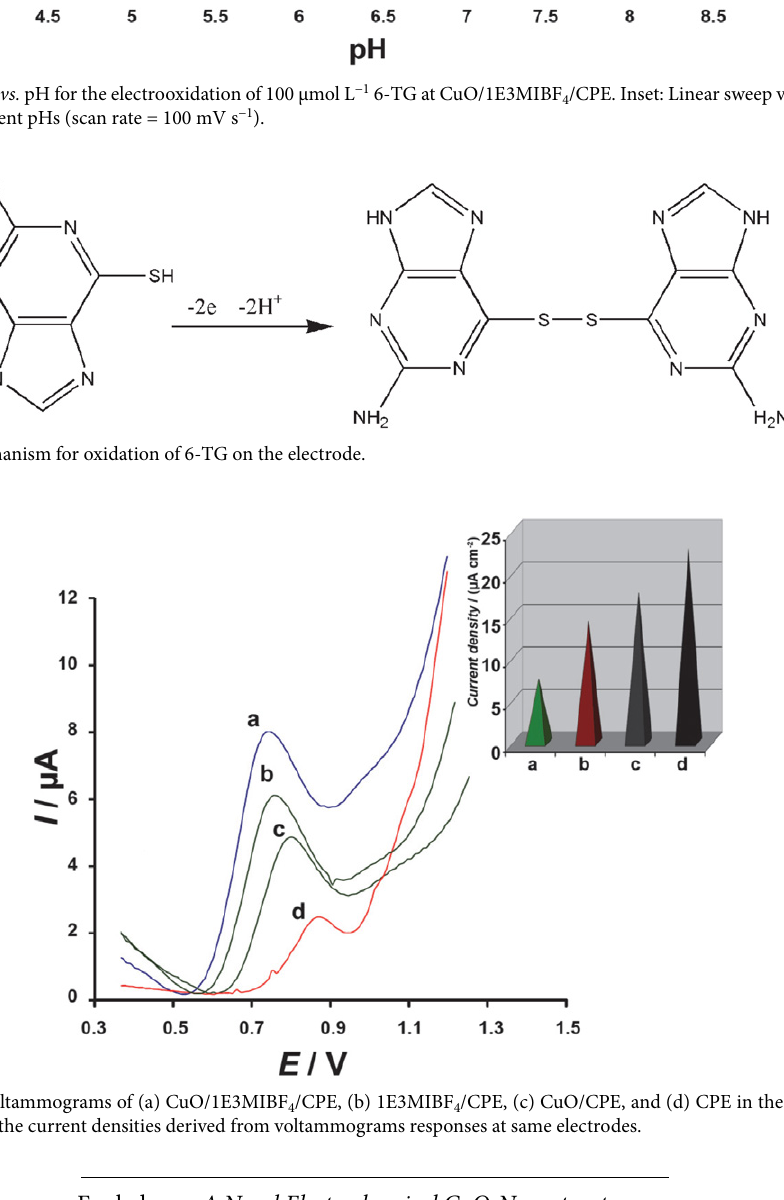
Fouladgar: A Novel Electrochemical CuO-Nanostructure ...